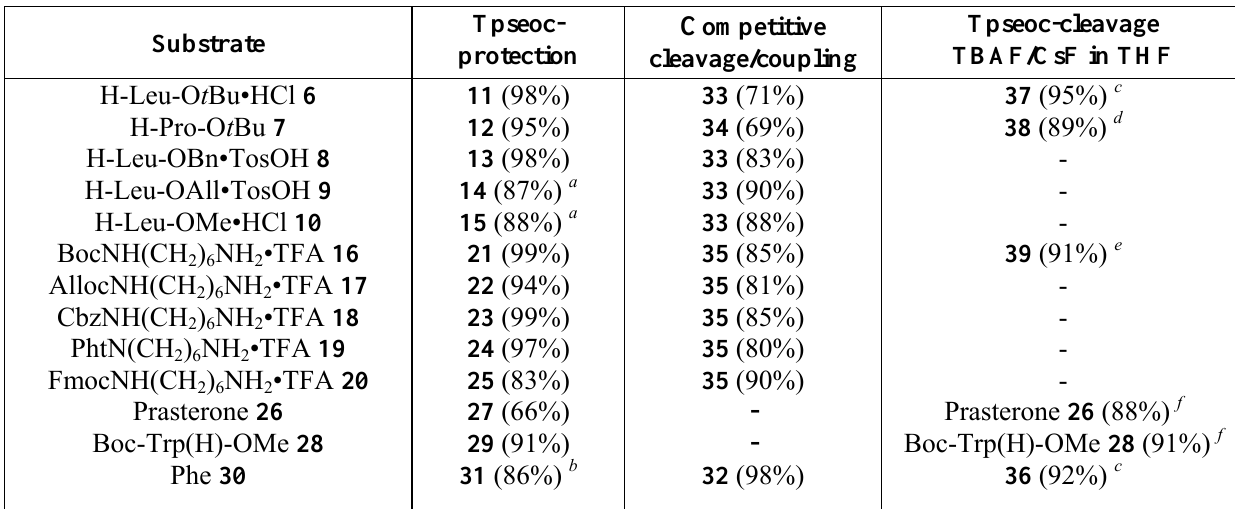
Table 1. Yields of protection and cleavage